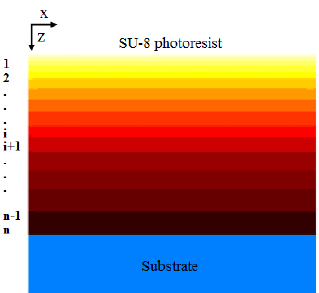
Figure 4. Schematic diagram of the concentration distribution of contents in thick SU-8 photoresist.